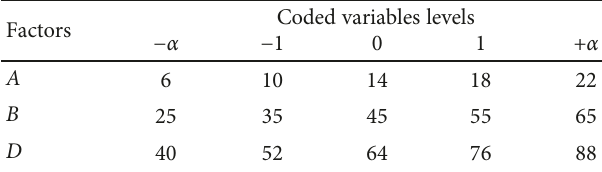
Table 5: Experimental variables and their coded levels for CCD. Factors